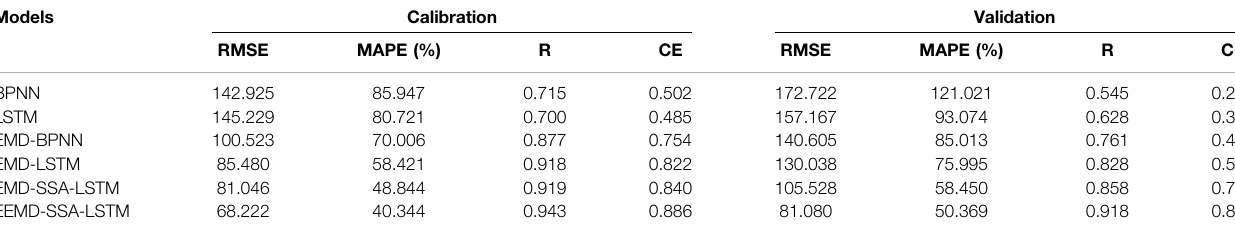
TABLE 4 | Comparison of evaluation indexes of different models for the Xinfengjiang Reservoir.